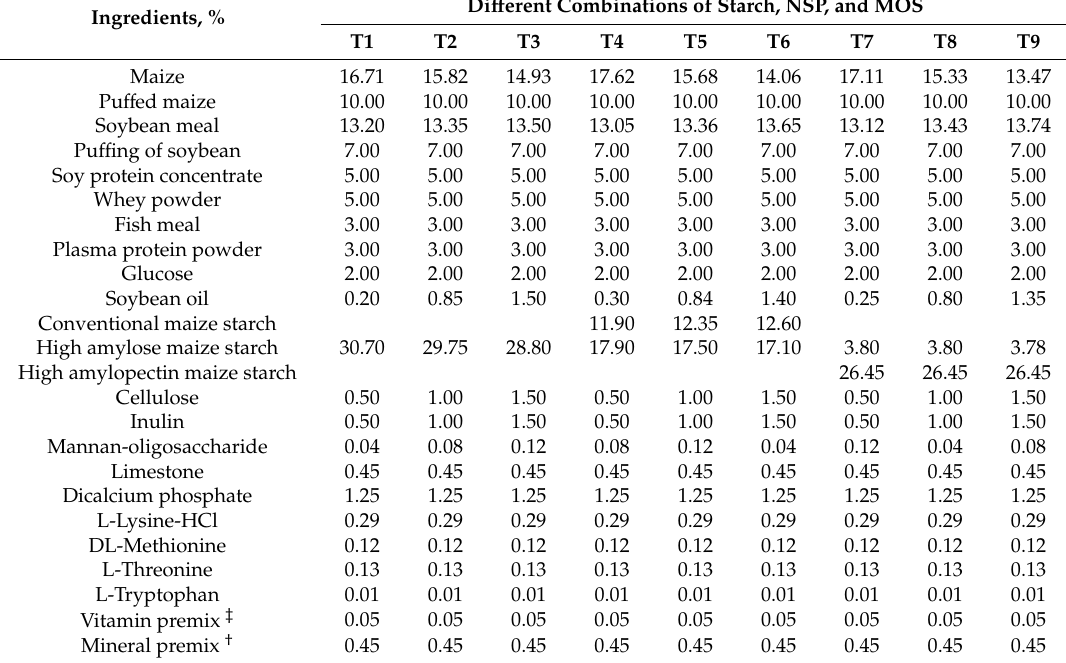
Table 2. Ingredients composition of experimental diets (as-fed